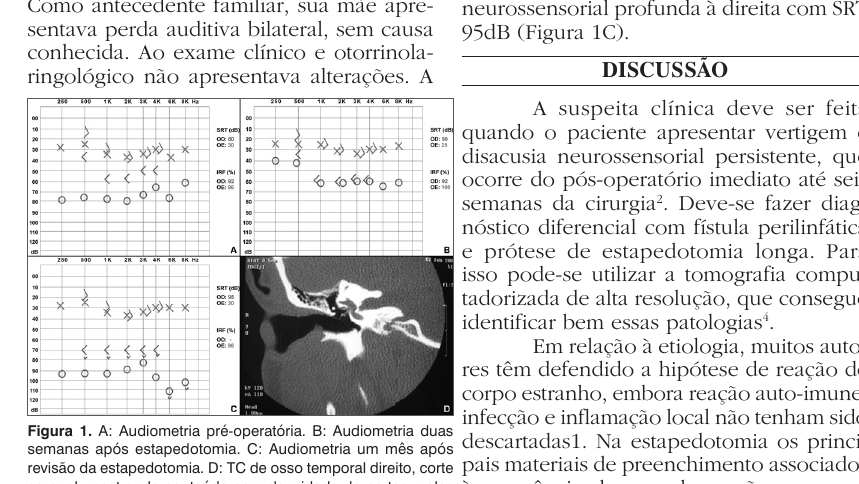
Figura 1. A: Audiometria pré-operatória. B: Audiometria duas semanas após estapedotomia. C: Audiometria um mês após revisão da estapedotomia. D: TC de osso temporal direito, corte coronal, mostrando conteúdo com densidade de partes moles envolvendo a região da janela oval e a